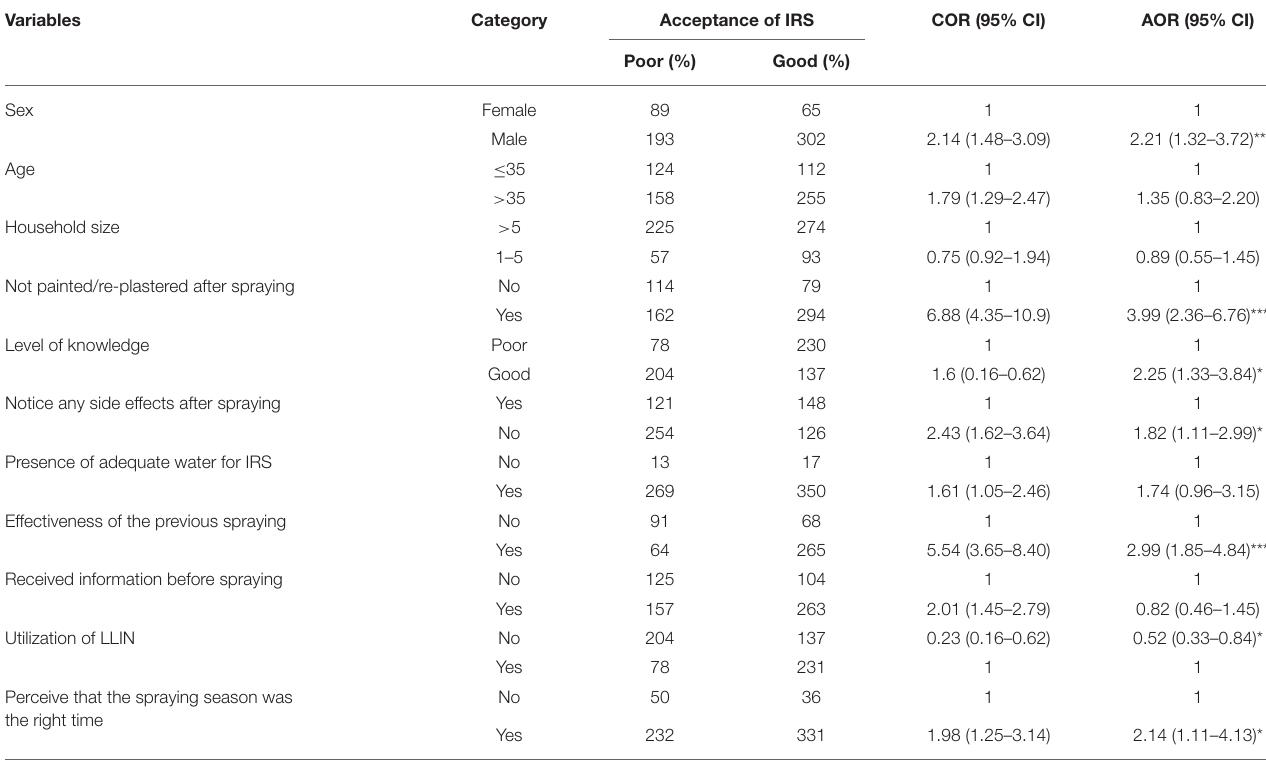
TABLE 6 | Multivariable analysis of factors associated with the acceptance of IRS in Shewa Robit, North Eastern Ethiopia, 2020.